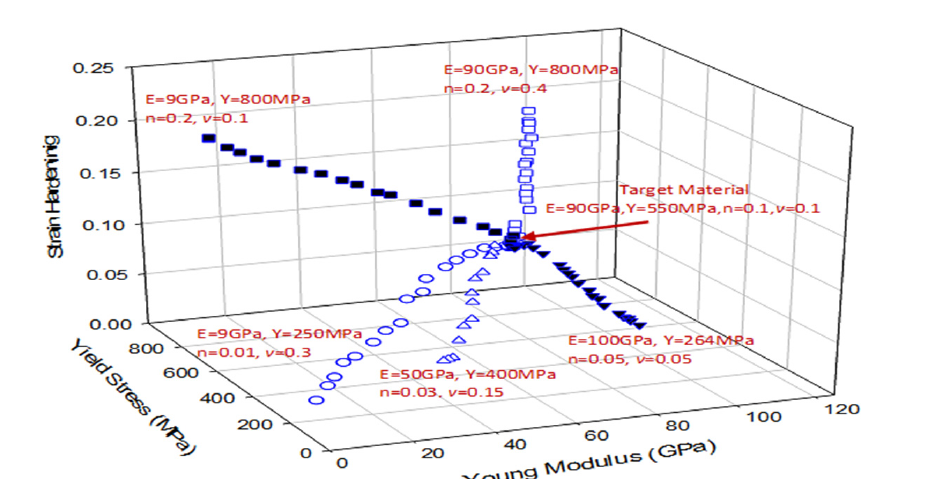
Figure 4. Converging trends of five initial guess values using spherical and Berkovich (S&B) dual indenter for ( a ) elastic plastic hardening target material.